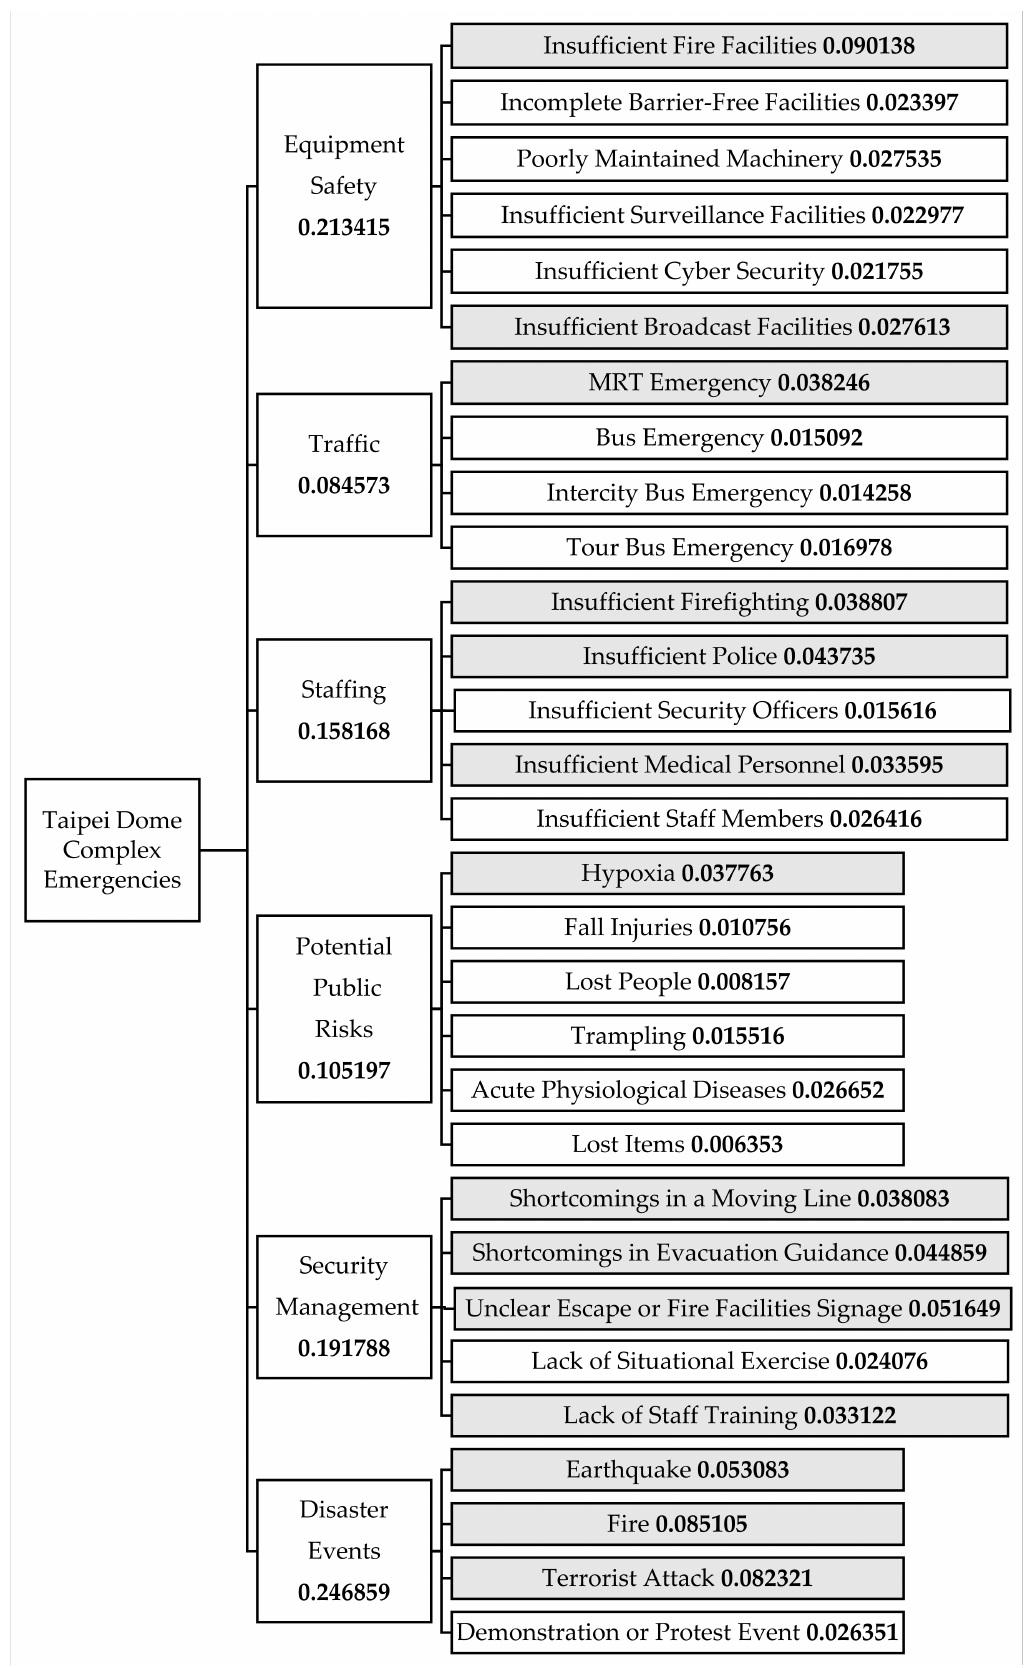
Figure 7. Hierarchical